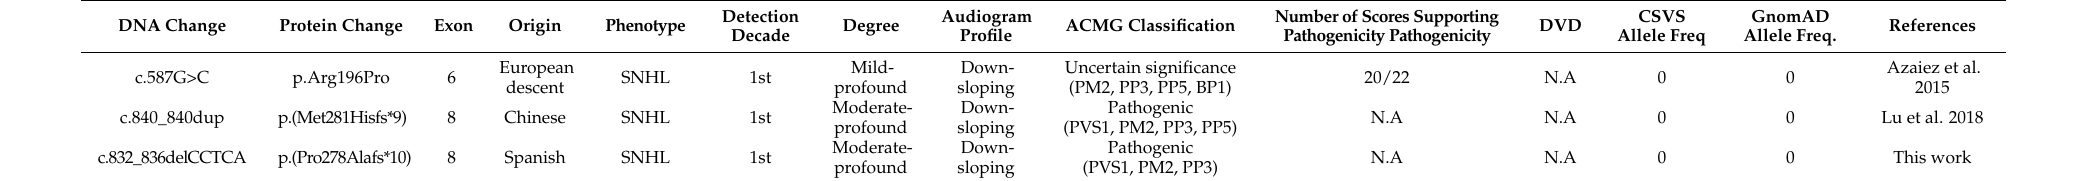
Table 2. Clinical data and classification of the different variants described in HOMER2 causing hearing